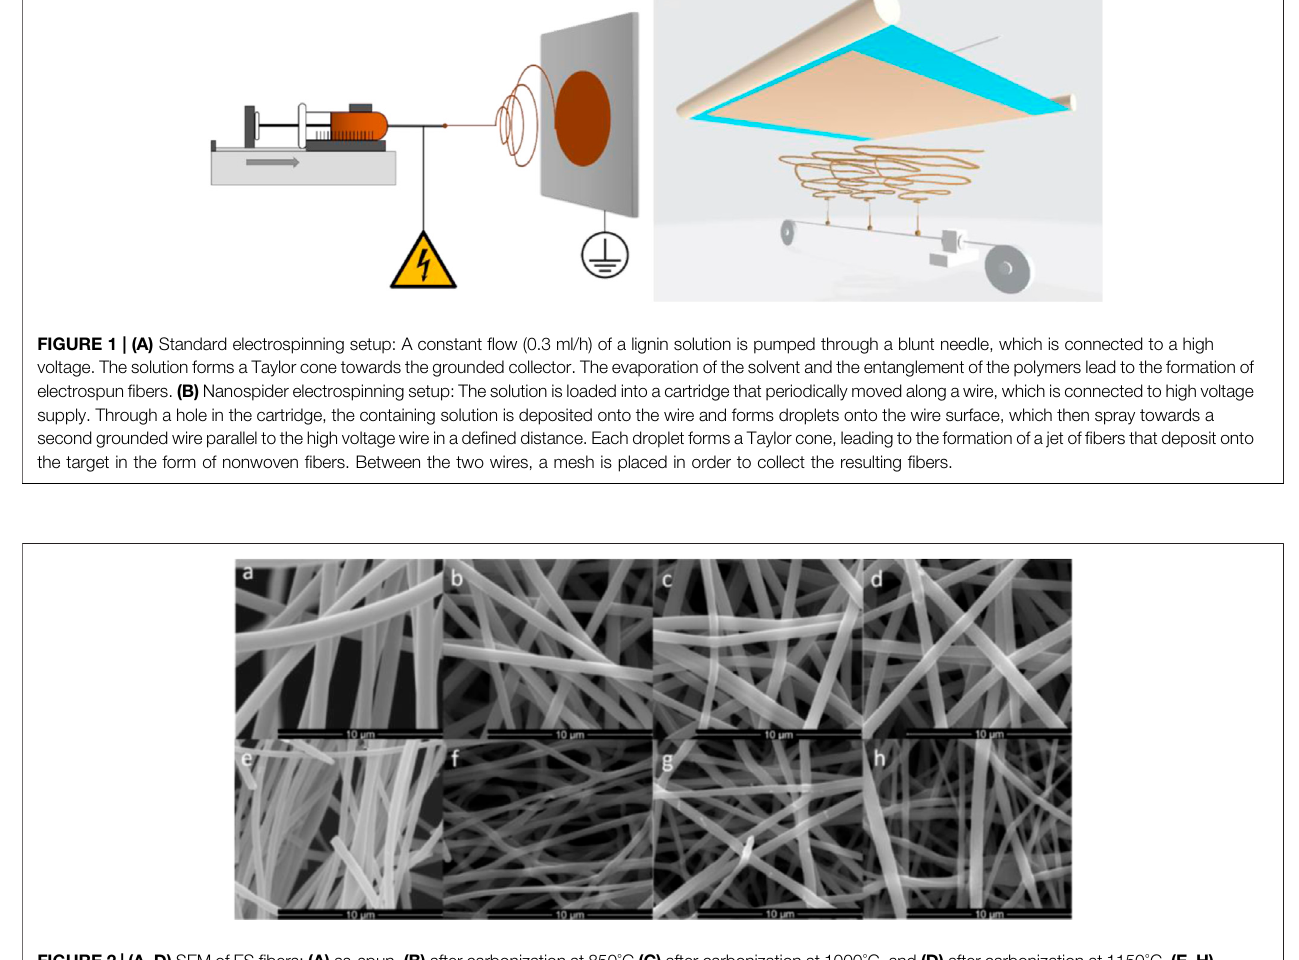
FIGURE 2 | (A – D) SEM of ES fi bers: (A) as-spun, (B) after carbonization at 850 ° C (C) after carbonization at 1000 ° C, and (D) after carbonization at 1150 ° C. (E – H) SEMofNS fi bers: (E) as-spun, (F) aftercarbonizationat850 ° C, (G) after carbonization at1000 ° C,and (H) aftercarbonizationat 1150 ° C.Theaverage fi berdiameterwas determined via ImageJ by taking the diameter of at least 150 fi bers per sample.